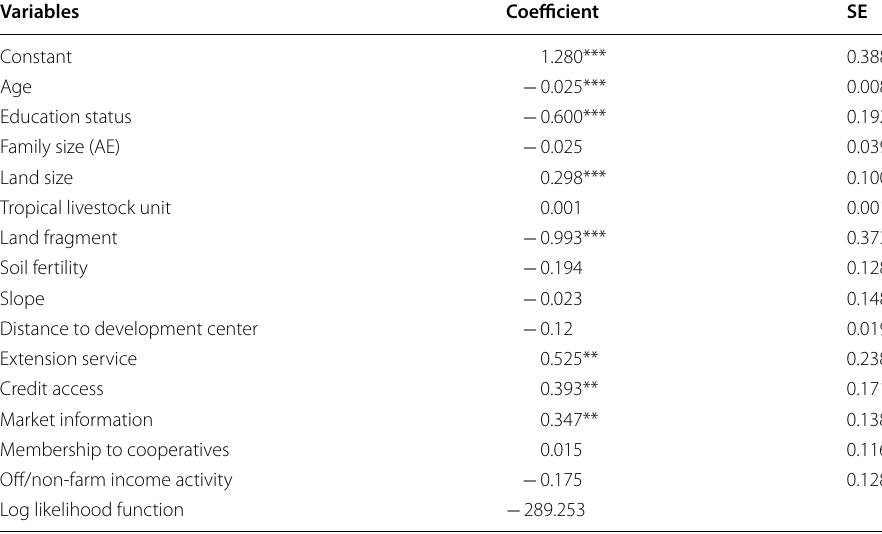
Table 4 Maximum likelihood estimates of factors affecting technical inefficiency Source : Model output